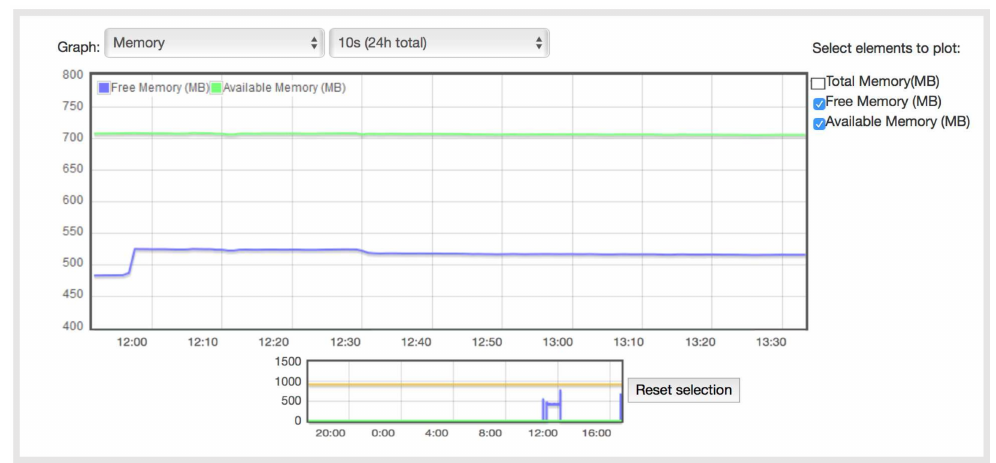
Figure 12. Raspberry RAM memory with the Python implementation.